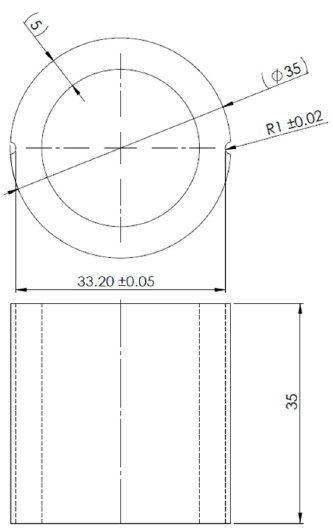
Figure 10. Drawing of notched ring specimen.